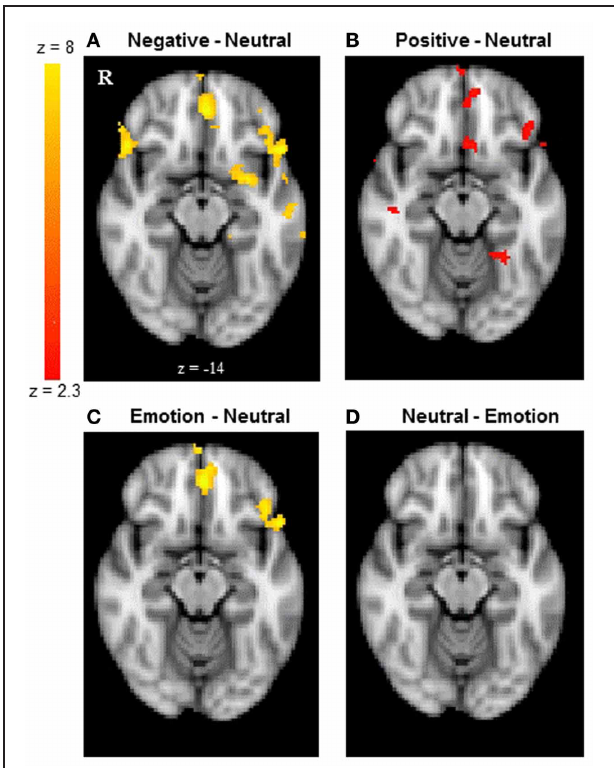
FIGURE 2 | The frontal pole and OFC showed similar activity between younger and older adults. The results shown here are collapsed across groups. (A) The frontal pole and OFC showed greater activity when participants reversed negative associations than neutral associations. (B) The positive-neutral contrast also showed a similar pattern of frontopolar OFC activity when a lower threshold (a voxel-threshold of z = 2 . 3) was used. Although the low-threshold map should be interpreted with caution, it provides useful information about the similarities between the positive and negative conditions in contrast with the neutral condition. (C) When positive and negative conditions were combined, the emotion condition showed greater activity in the frontal pole and OFC than did the neutral condition, (D) whereas the reverse contrast showed no significant findings. The images were thresholded at the whole-brain level using clusters determined by z > 2 . 3 and a (corrected) cluster significance threshold of p = 0 . 05, except for panel (B)